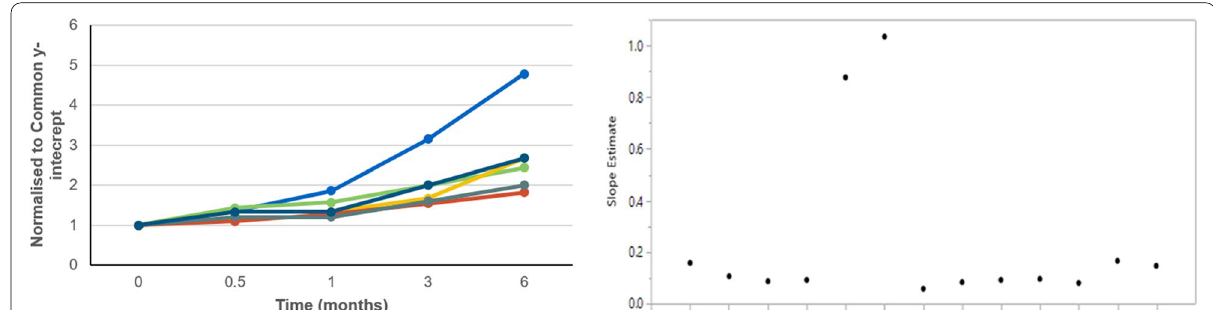
Fig. 4 Kinetics of Impurity Formation under Accelerated Conditions. Excerpt from Lennard, A., Taking Stability Off the Critical Path of Vaccine Product Development, AAPS Vaccine Stability Workshop, March 24‑25,